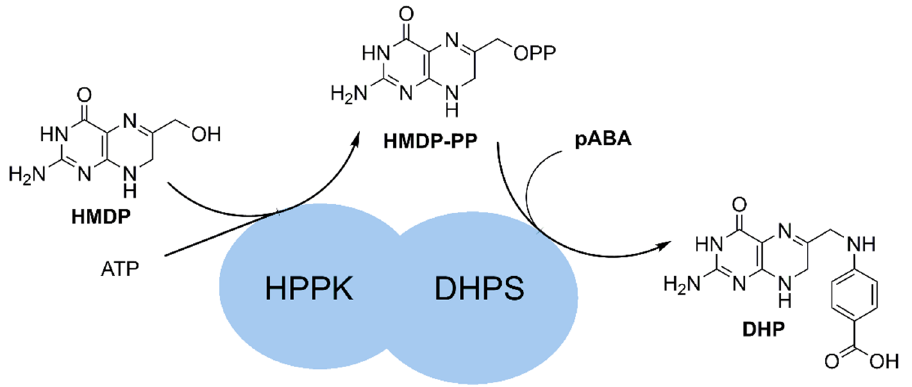
Figure 1. Reaction catalyzed by Pf HPPK-DHPS.